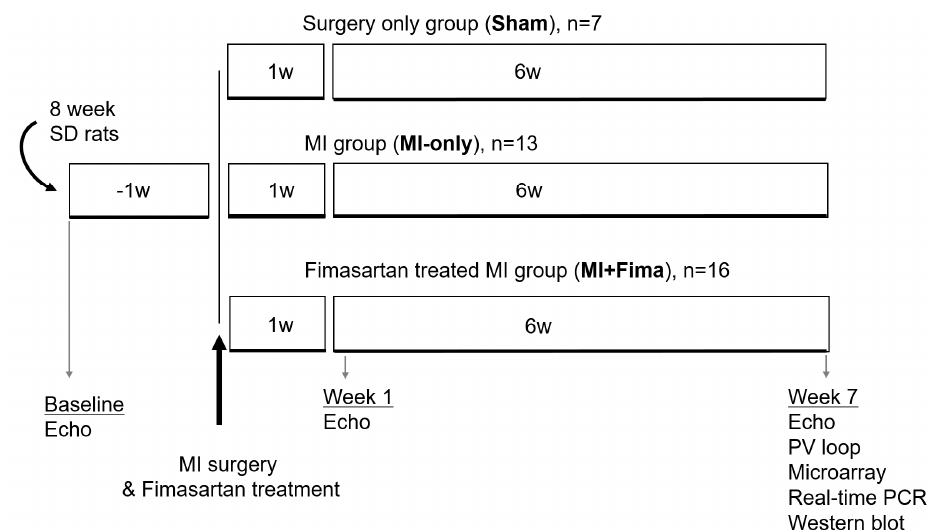
Figure 1. A schematic diagram of the experimental protocol. echo, echocardiography; Fima, fimasartan; MI, myocardial infarction; PCR, polymerase chain reaction; SD, Sprague–Dawley; PV, pressure–volume; w, week.